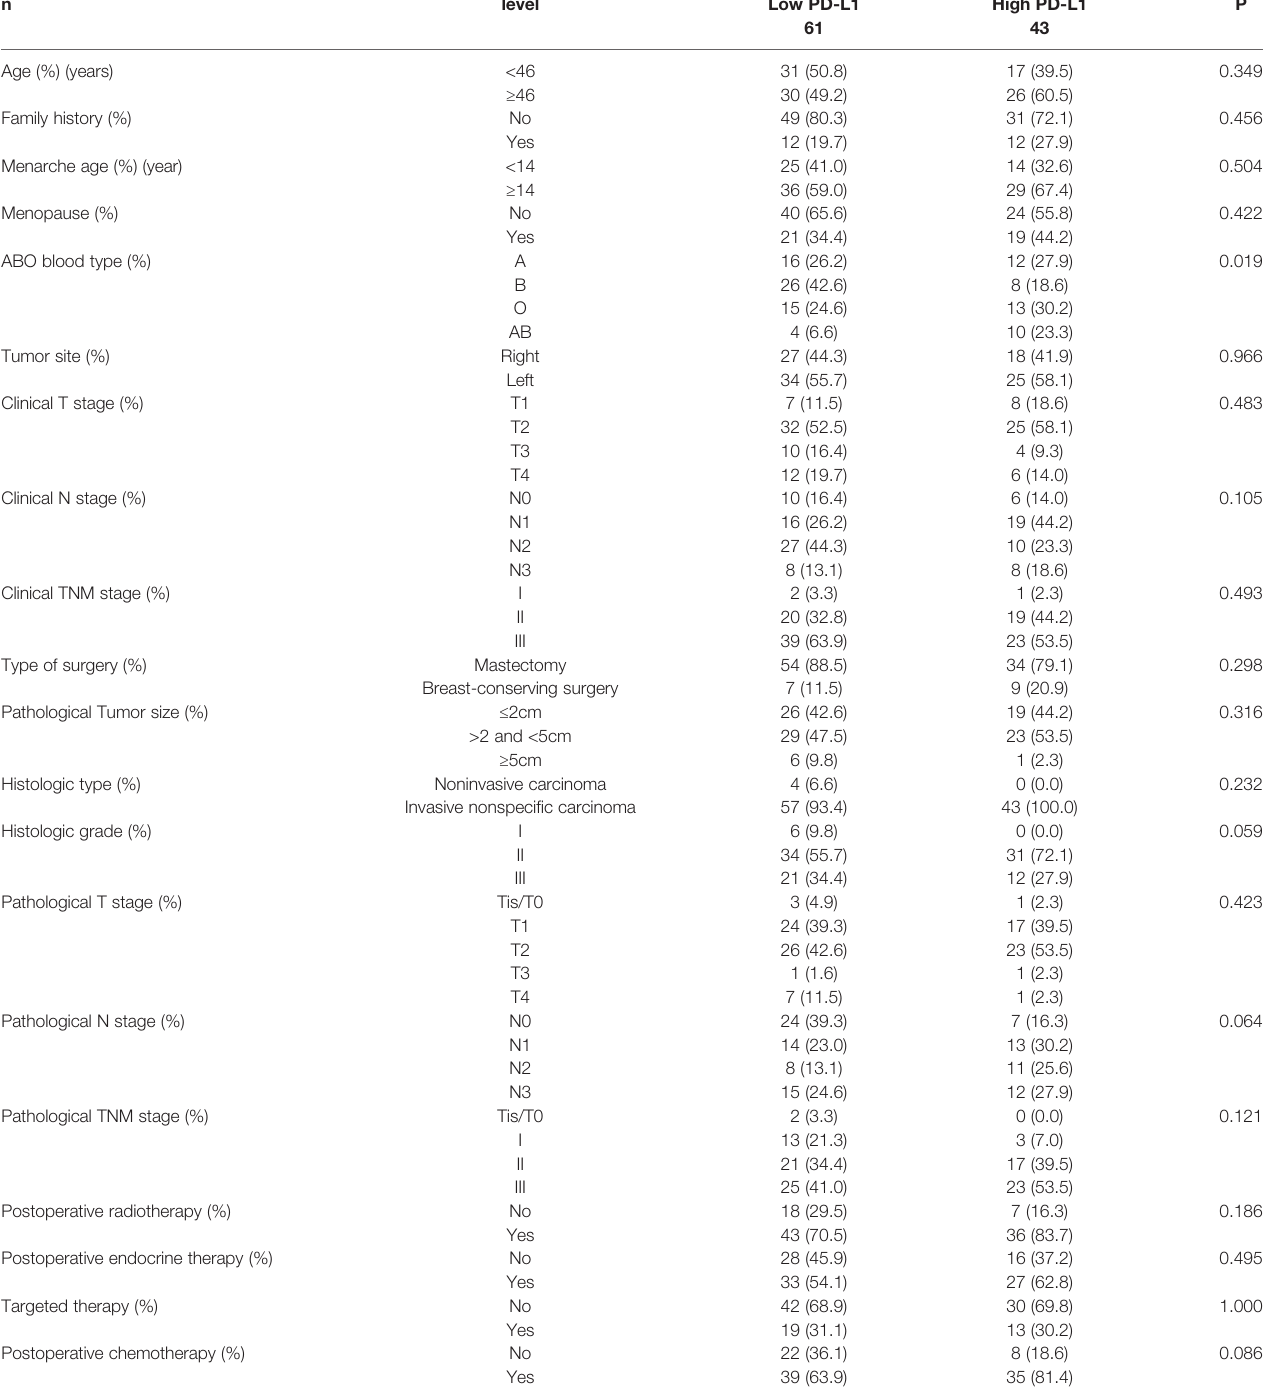
TABLE 1 | Patients ’ characteristics for all patients according to programmed cell death ligand-1